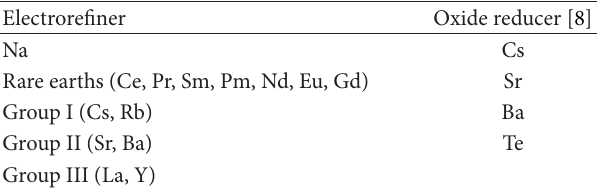
Table1:Majorcontaminantsoftheelectrorefinerandoxidereducer.